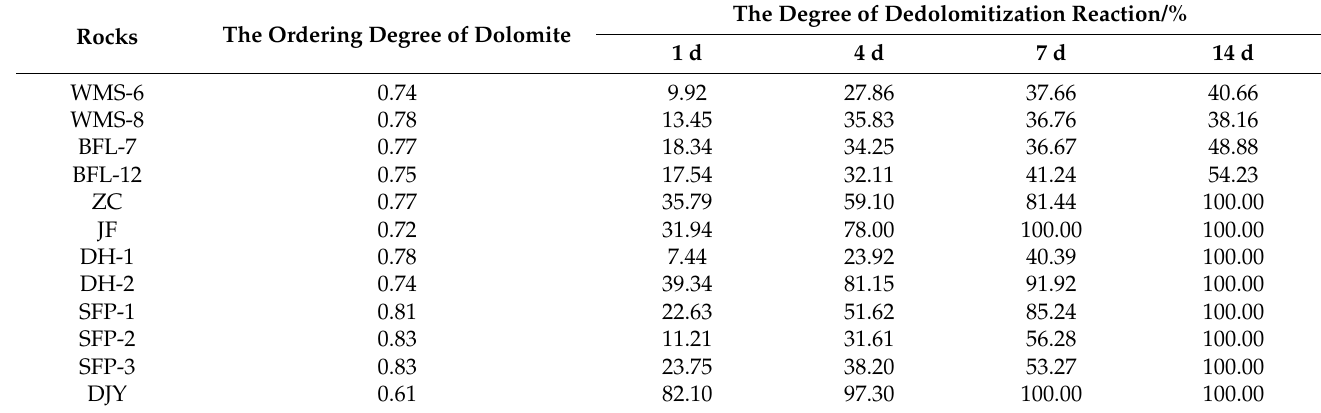
Table 3. The ordering degree of dolomite and degree of dedolomitization reaction.